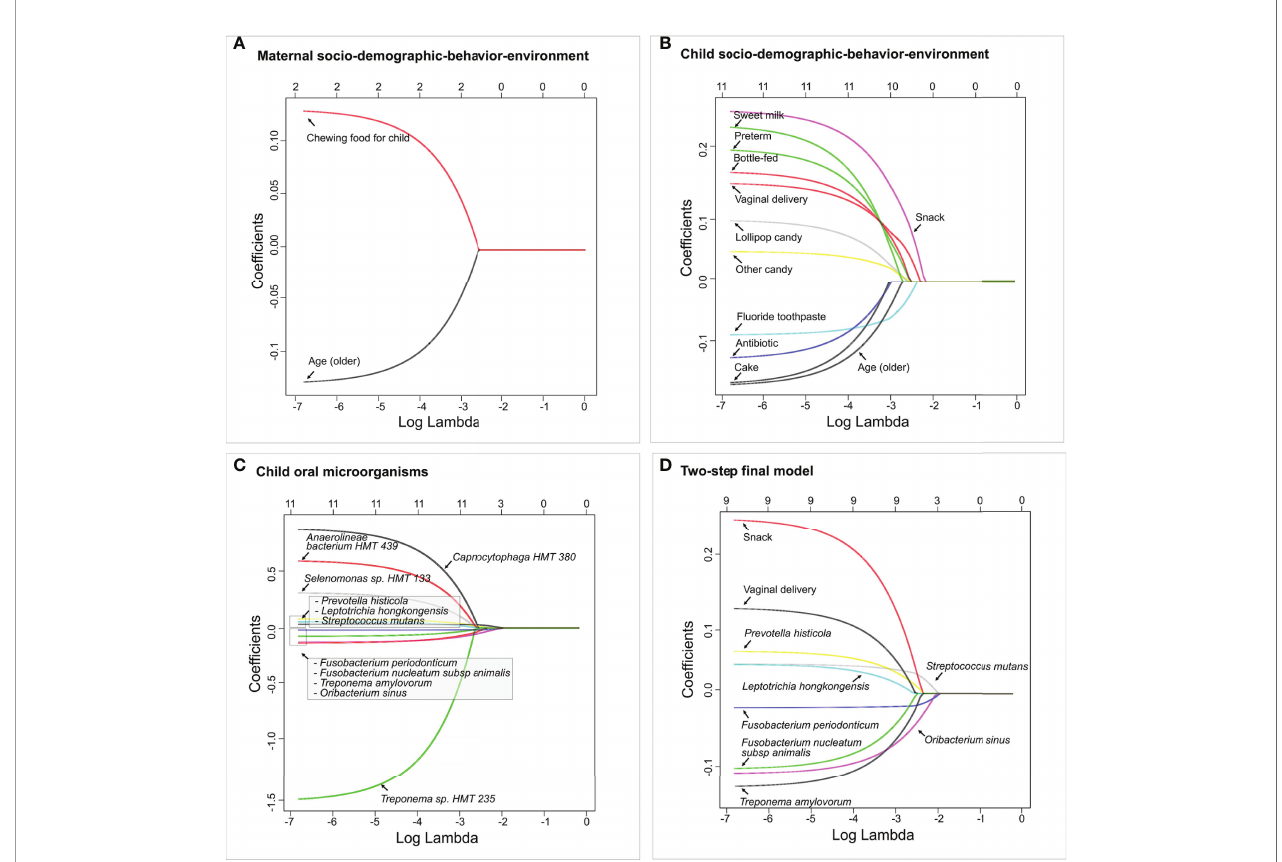
FIGURE 6 | Identi fi ed factors associated with child ’ s caries risk using factors via two-step model. LASSO penalized logistic regression modeling was used for caries predictor selection based on 413 variables, including children ’ s saliva samples. Speci fi cally, variables from three separate platforms were identi fi ed shown in (A) Maternal socio-demographic-behavior-environmental factors, (B) Children ’ s socio-demographic-behavior-environmental factors, and (C) Children ’ s salivary microorganisms. The fi nal two-step model using variables identi fi ed from (A – C) is shown in (D) . The LASSO solution path above shows how the model is built sequentially by adding one variable at a time to the active set. The 2-step predictive model is the following (area under the curve: